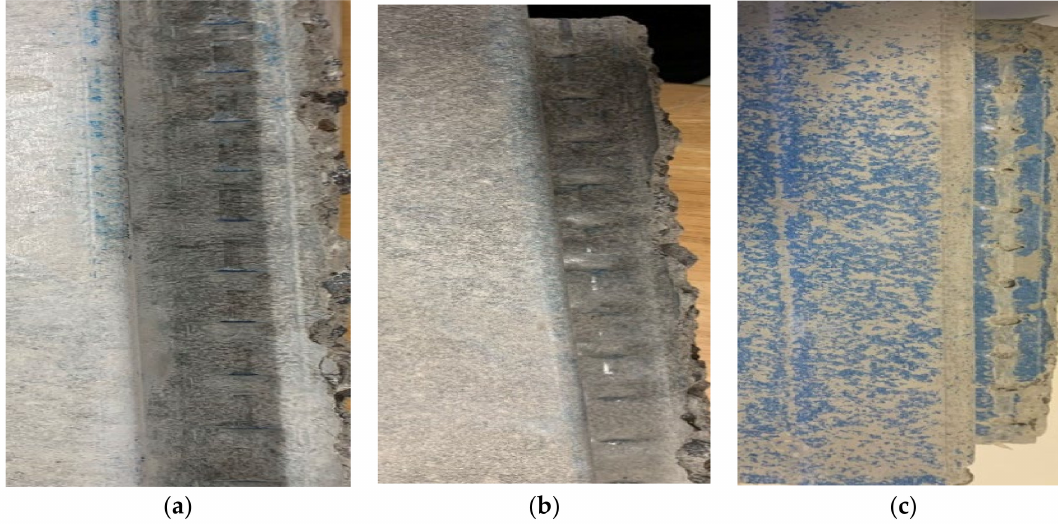
Figure 18. Precise observation of indentions in concrete. ( a ) NC40. ( b ) NC60. ( c )